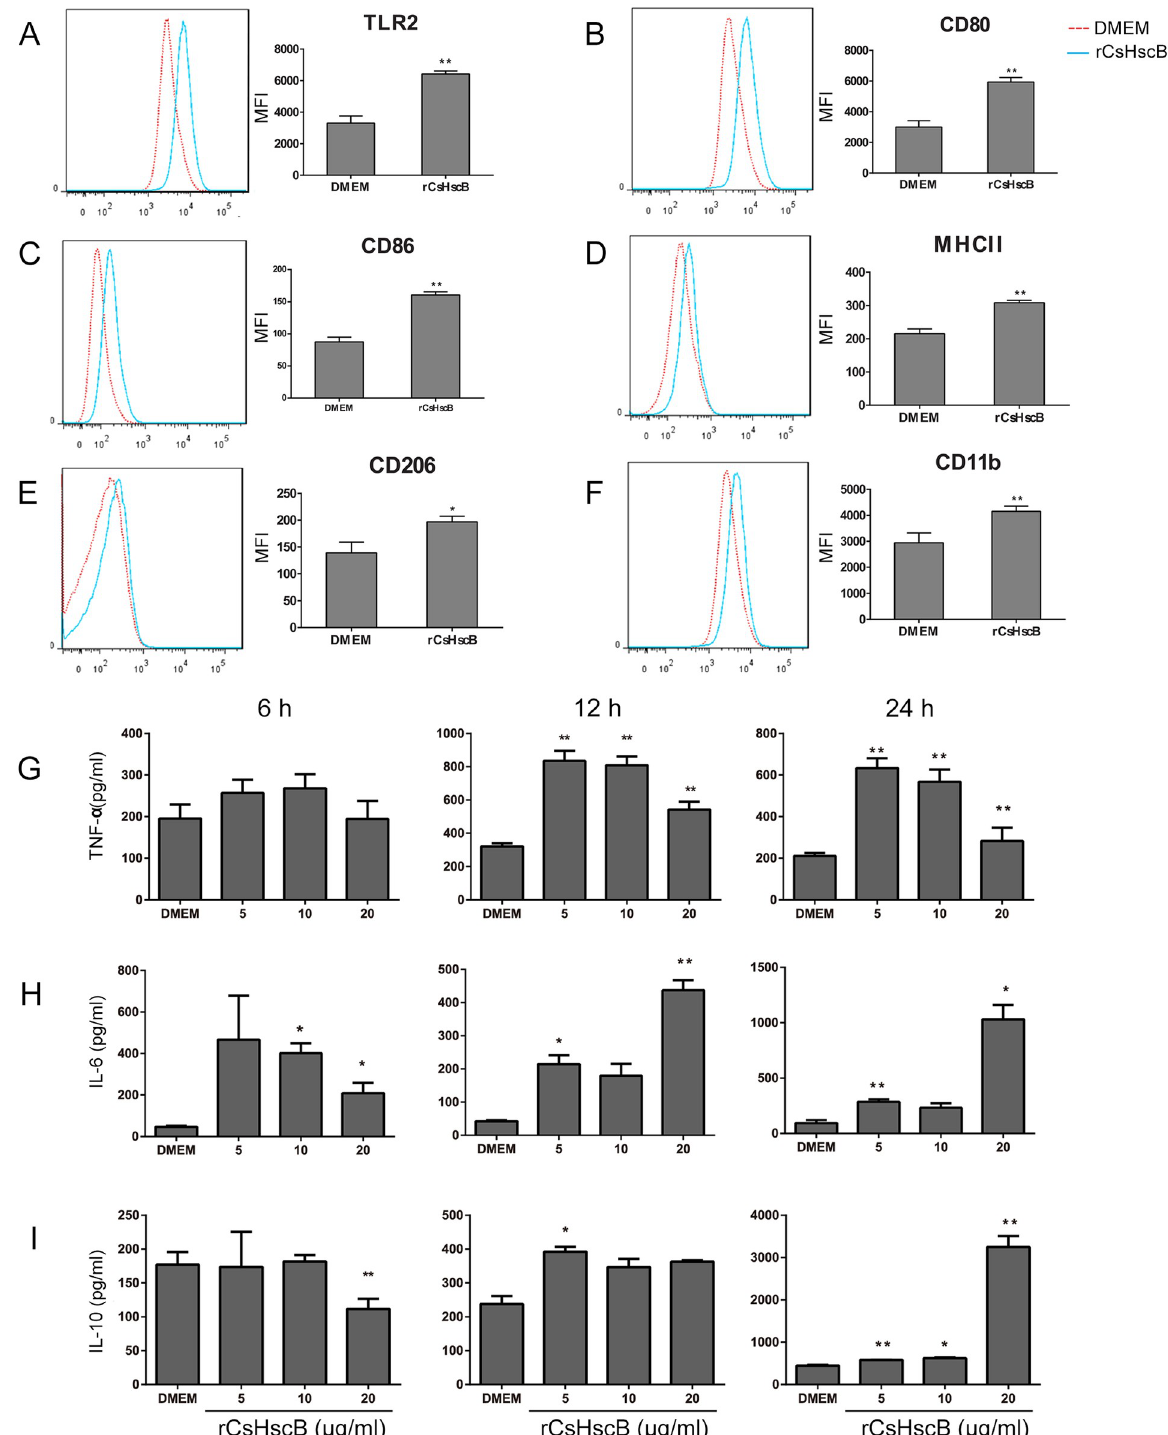
Fig 2. rCsHscB induces the activation of macrophage and cytokine production. (A~F) rCsHscB increased the expression of macrophage activation markers by flow cytometry. (G~I) productions of TNF- α (G), IL-6 (H), and IL-10 (I) were assayed for ELISA in the macrophage stimulated by indicated concentrations of rCsHscB for different time courses. Quantitative data are the mean ± SE of three independent experiments, and all data shown are representative of at least three independent experiments (n = 4~5). � P < 0.05, �� P < 0.01, and ��� P < 0.001, stimulated cells versus those cultured in medium